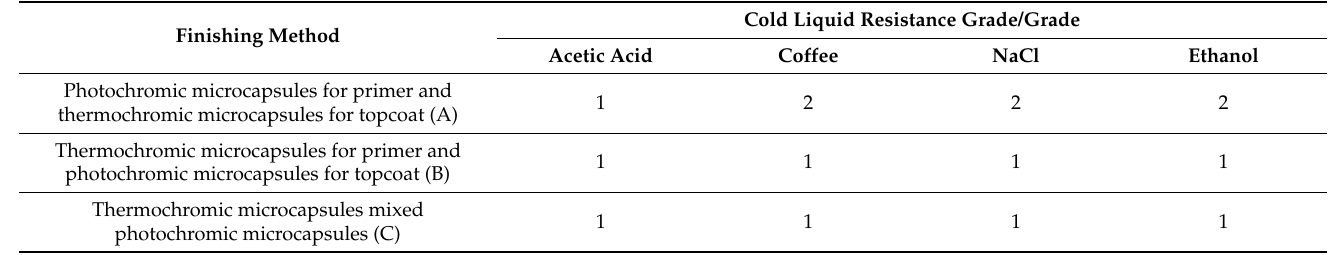
Table 12. Cold liquid resistance grade of coating under different coating